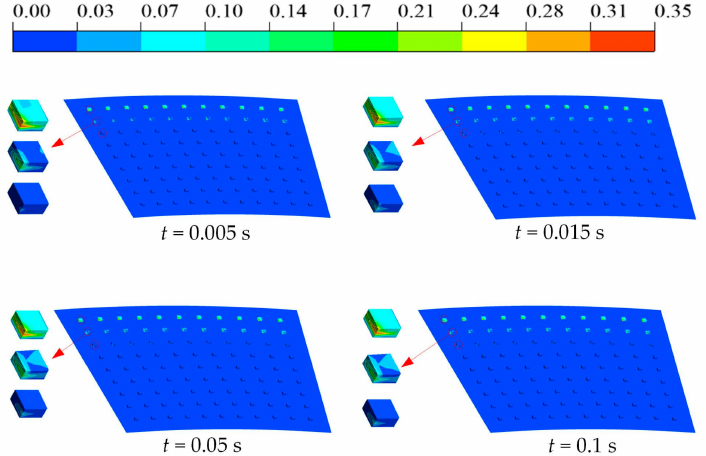
Figure 18. Cavitation morphology change with hexahedral texture rate 3.205%.